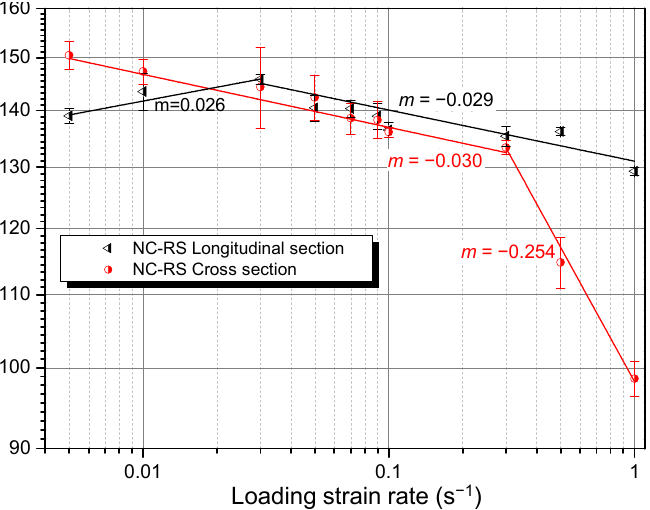
Figure 7. Room temperature strain rate sensitivity of cross and longitudinal sections of the NC Mg–Gd–Y–Zr alloy.